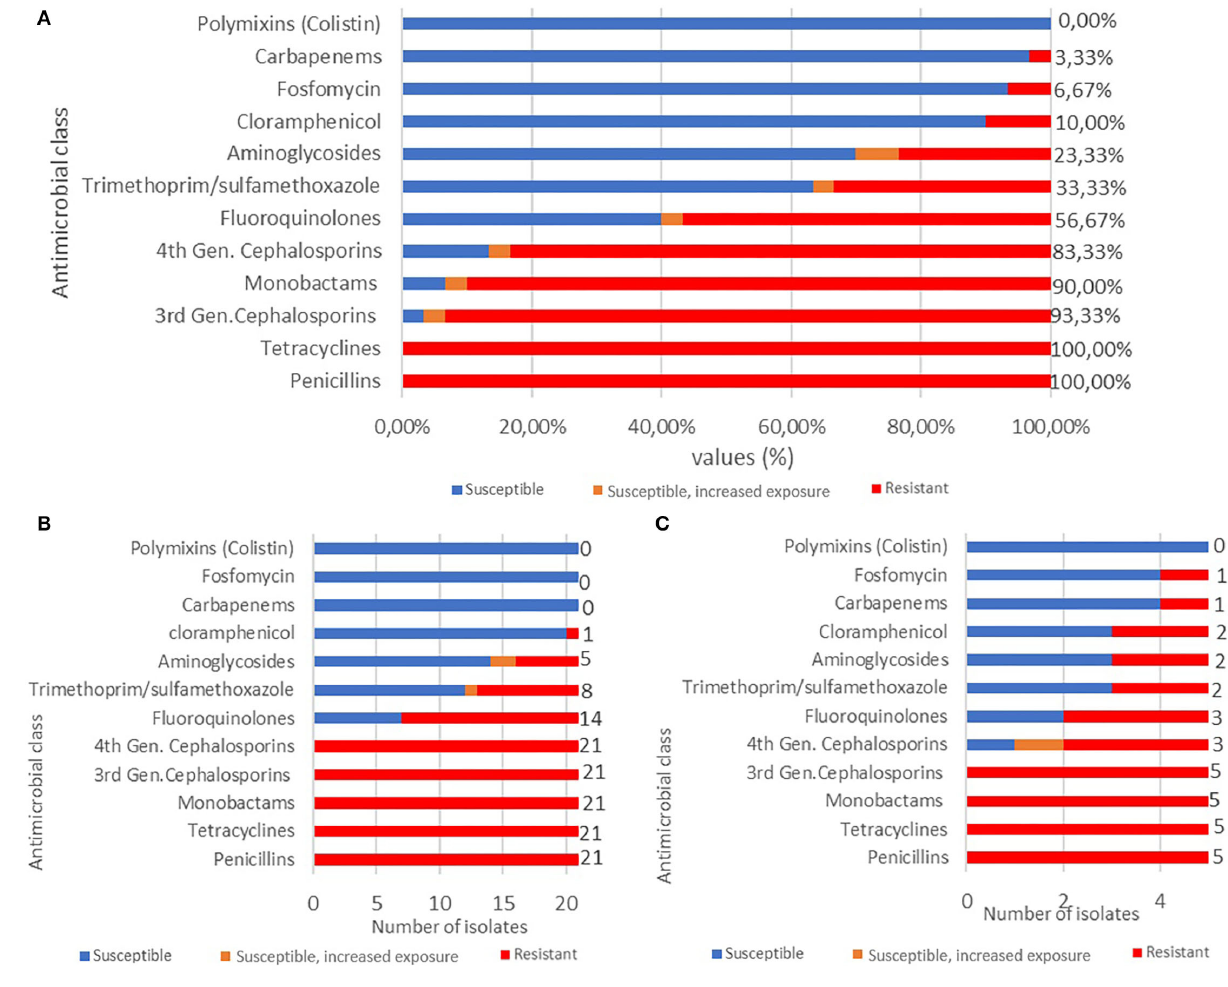
E. coli isolates ( n = 13) exhibited a MDR